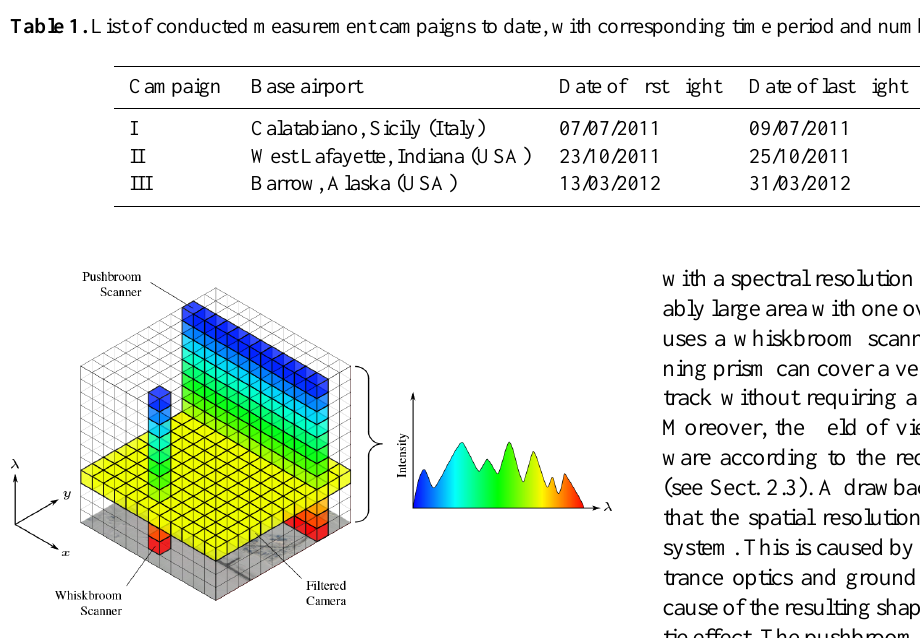
Figure 1. The hyperspectral cube is an often used schematic to vi- sualize the different recoding techniques in hyperspectral imaging. Two dimensions of the cube represent the spatial dimensions of the image ( x , y ), while the third axis represents the spectral dimension (i.e., the wavelength λ ). For spectral images the whole cube has to be scanned. As can be seen, the whiskbroom technique can only acquire one pixel at a time with spectral information. So, scanning in two spatial dimensions is necessary to take spectral images. The pushbroom technique records a whole swath with spectral informa- tion at once and only needs to scan in one spatial dimension. A camera equipped with band-pass filters can take both spatial dimen- sions at once but will only contain spectral information from one narrow wavelength